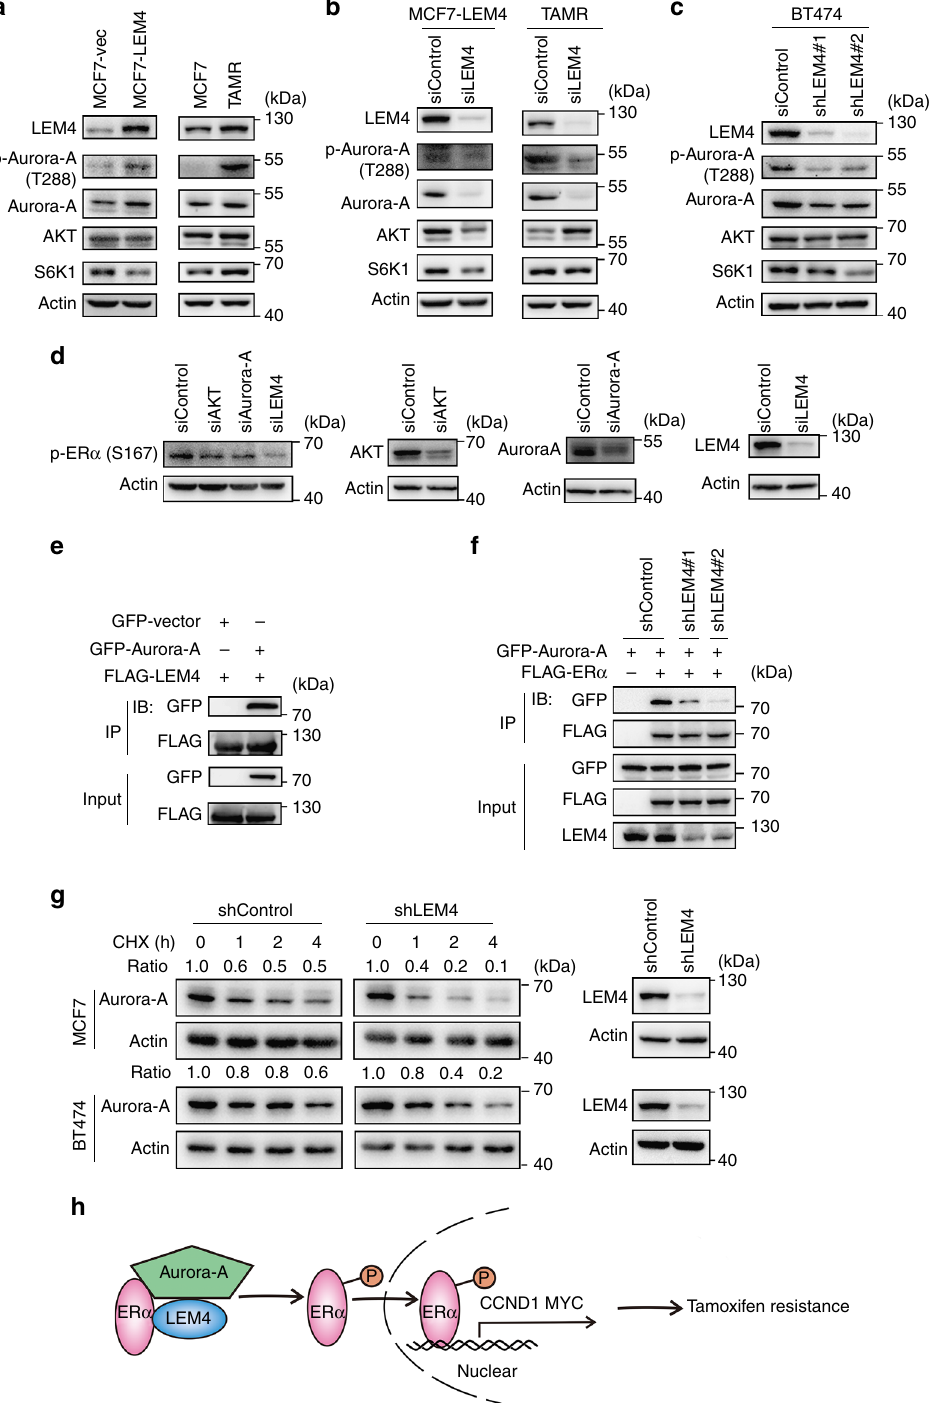
Fig. 8 LEM4 mediated the phosphorylation of ER α -Ser167 by Aurora-A. a Immunoblot analysis of the phosphorylation of Aurora-A, Aurora-A, AKT, and S6K1 in MCF7-LEM4 and MCF7-TAMR cells. b LEM4 siRNA-treated and control siRNA-treated MCF7-LEM4 and MCF7-TAMR cells were treated for 48 h. Western blot was performed with indicated antibodies. c BT474 cells were transfected with LEM4 siRNA or control siRNA for 48 h. Western blot was performed with indicated antibodies. d MCF7-LEM4 cells were transfected with LEM4 siRNA or AKT siRNA or Aurora-A siRNA for 48 h. Western blot was performed with indicated antibodies. e HEK293T cells were transfected with FLAG-LEM4 and GFP-Aurora-A. After incubating for 48 h, cell lysates were precipitated with anti-FLAG af fi nity gel and immunoblotted with anti-GFP antibody. f HEK293T-shLEM4 cells were transfected with FLAG-ER α and GFP- Aurora-A. After incubating for 48 h, cell lysates were precipitated with anti-FLAG af fi nity gel and immunoblotted with anti-GFP antibody. g MCF7- shControl and MCF7-shLEM4 cells, or BT474-shControl and BT474-shLEM4 cells were treated with 50 μ g mL − 1 CHX for 0, 1, 2, and 4 h and analyzed for Aurora-A by immunoblot. h Model of LEM4 regulation of the ER α signaling leading to tamoxifen resistance in ER + breast